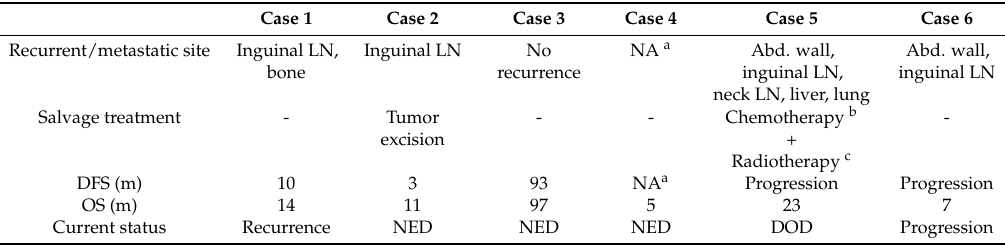
Figure 2. Representative image studies of recurrent tumors. ( A ) CT scan showed a 2.0 cm enlarged lymphadenopathy (arrow) in the left inguinal area (case 2). ( B ) Whole body bone scan demonstrated hot areas at the thoracic and lumbar spine (arrows) (case 1). ( C ) CT scan showed a 4.0 cm necrotic mass suggesting metastases at the left neck area (star) (case 5). ( D ) CT scan showed a 6.0 cm tumor at the lateral and medial segments of the liver (star) (case 5). ( E ) CT scan exhibited a 0.7 cm pulmonary nodule at the superior segment of the right lower lobe (arrow) (case 5). Table 2. Clinical outcomes of the six patients with clear cell carcinoma of the abdominal wall.